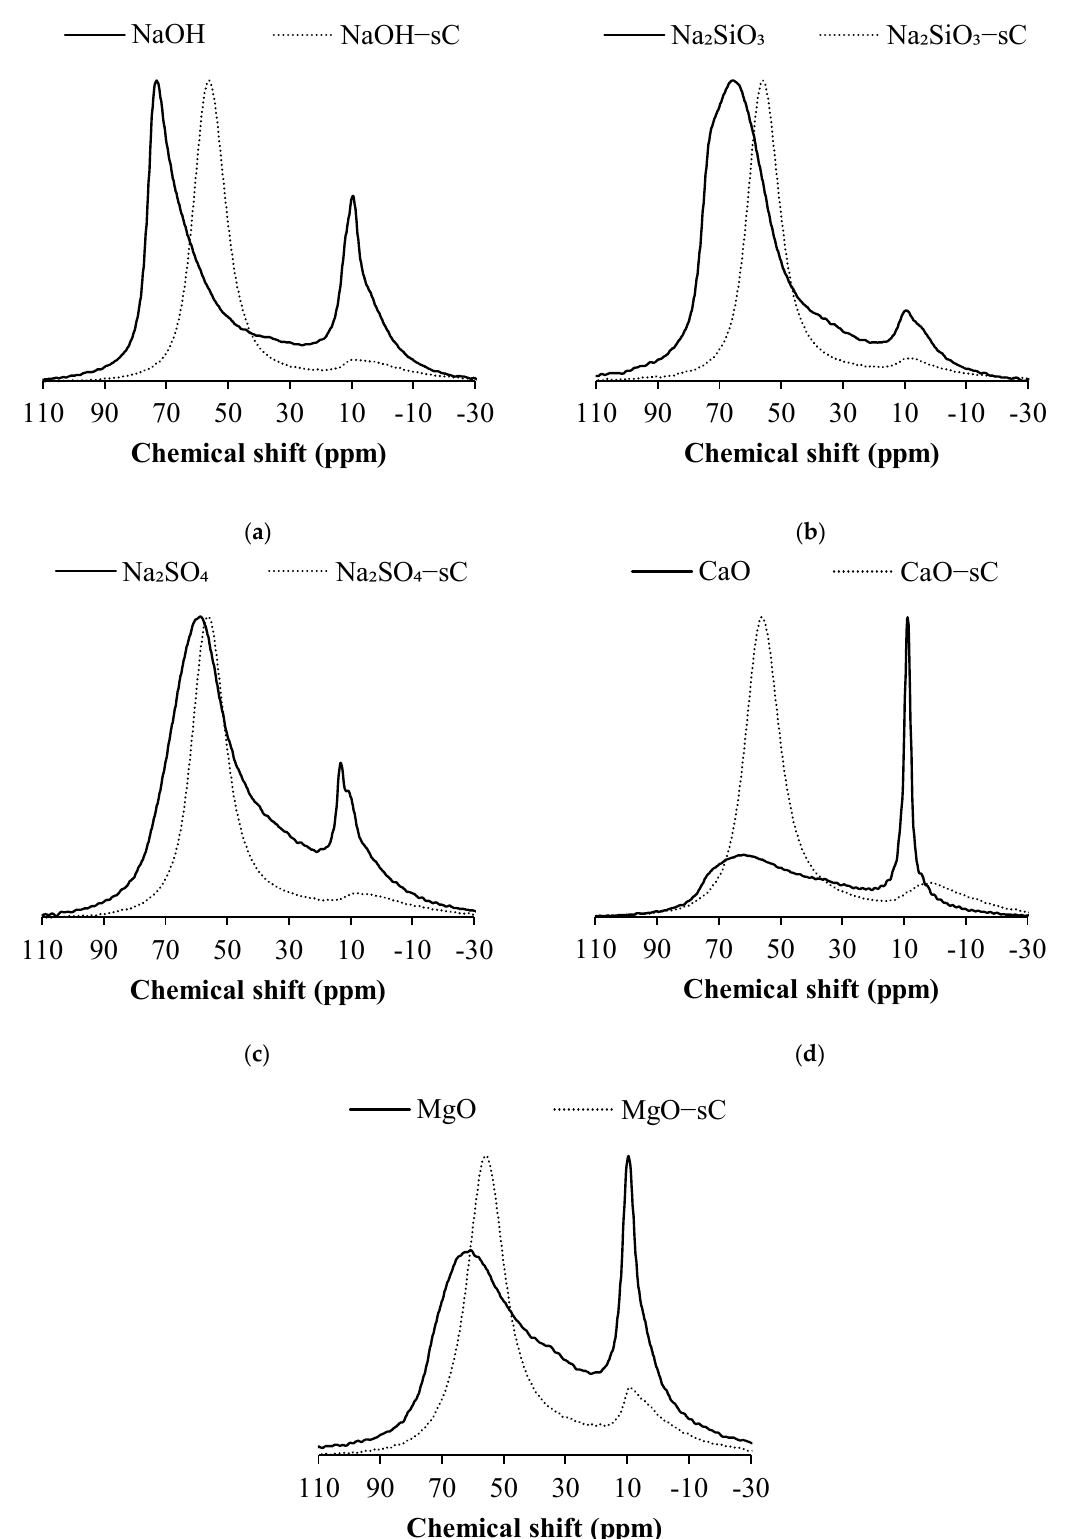
Figure 4. 27 Al MAS NMR spectra of activated slag before and after being exposed to sCO 2 . ( a ) NaOH ( b ) Na 2 SiO 3 ( c ) Na 2 SO 4 ( d ) CaO ( e ) MgO. The samples exposed to sCO 2 are shown in dotted lines. Uncarbonated samples of Na 2 SO 4 -activated slag have two prominent resonance zones similar to NaOH and Na 2 SiO 3 . The first resonance site peaks at approximately 60 ppm and consists of overlapped resonance sites at 63 and 58 ppm which corresponds to the q 3 and q 4 sites in highly cross-linked aluminosilicates. Resonance events correspond- ing to the lower coordination units are in small numbers indicating the C-S-H is more cross-linked compared to the NaOH and Na 2 SiO 3 systems. The resonance at 13 ppm cor- responds to the presence of Al in octahedral coordination in ettringite. In CaO-activated slag samples, a resonance site peaks at approximately 60 ppm and consists of overlapped resonance sites at 73, 68, 63, and 58 ppm which corresponds to the q 2 (I), q 2 (II), q 3 , and q 4 sites aluminosilicates, respectively. The resonance at 8 ppm outweighs the first resonance event and it is attributed to the resonance of Al in AFm phases. The MgO-activated sam- ples also produce resonance at similar sites of other activators; however, the resonance at 10 ppm has larger intensity and is contributed by hydrotalcite and AFm phases.